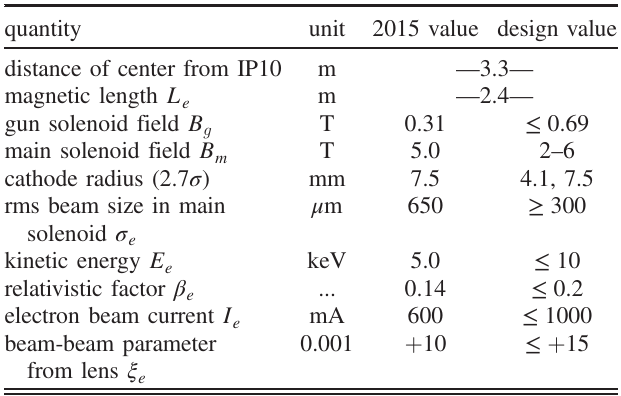
TABLE I. Typical electron lens parameters for 2015 (100 GeV proton energy) and design values (for up to 255 GeV) [1].